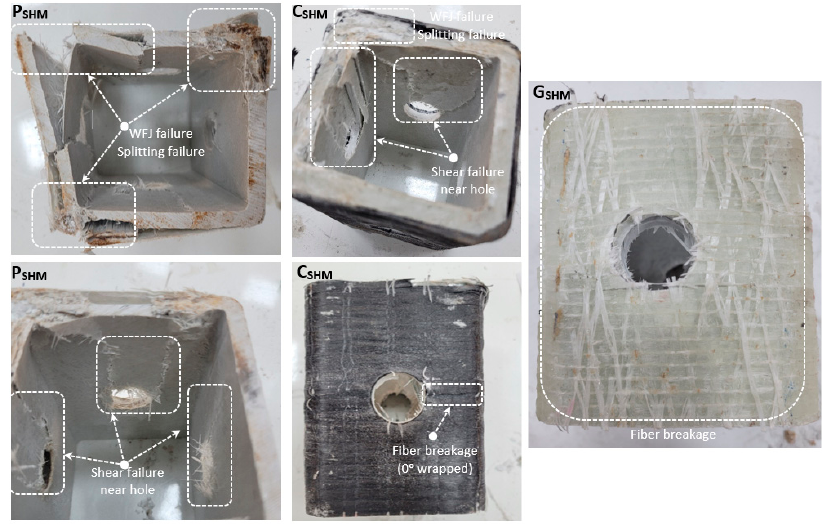
Figure 4. Damage analyses of P SHM , C SHM , G SHM .